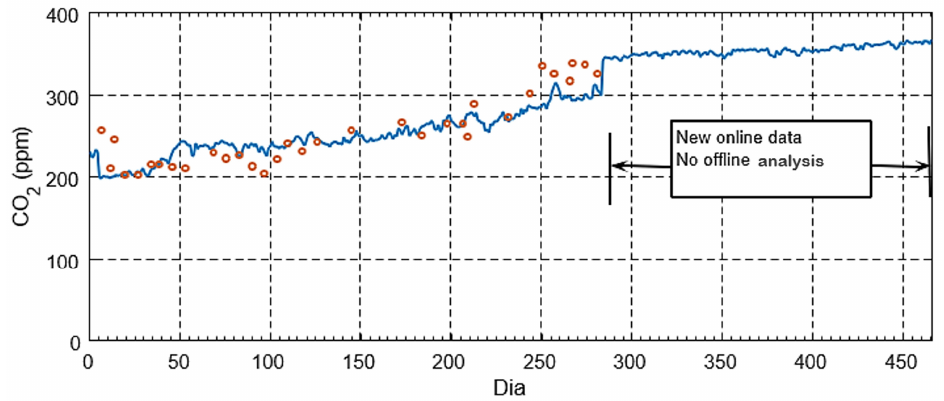
Figure 55. Evolution of carbon dioxide concentration over time, online (blue) and offline (orange) data.